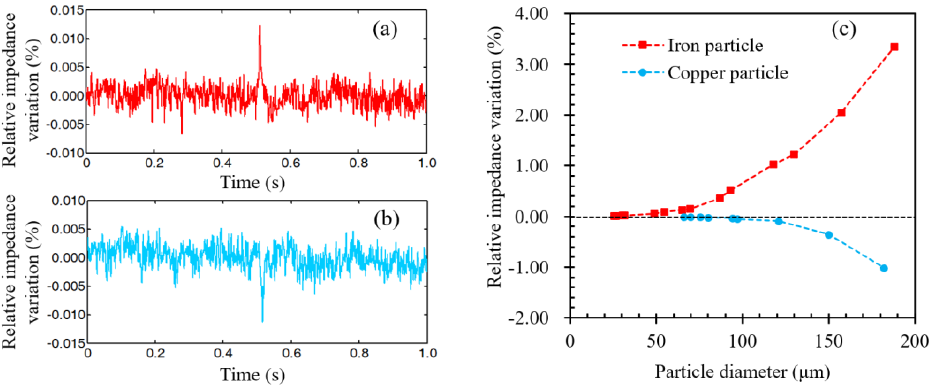
Figure 13. ( a ) The relative impedance variation of the 25 µ m iron particle, ( b ) the relative impedance variation of the 66 µ m copper particle, and ( c ) comparison of the induced signals by ferrous and nonferrous